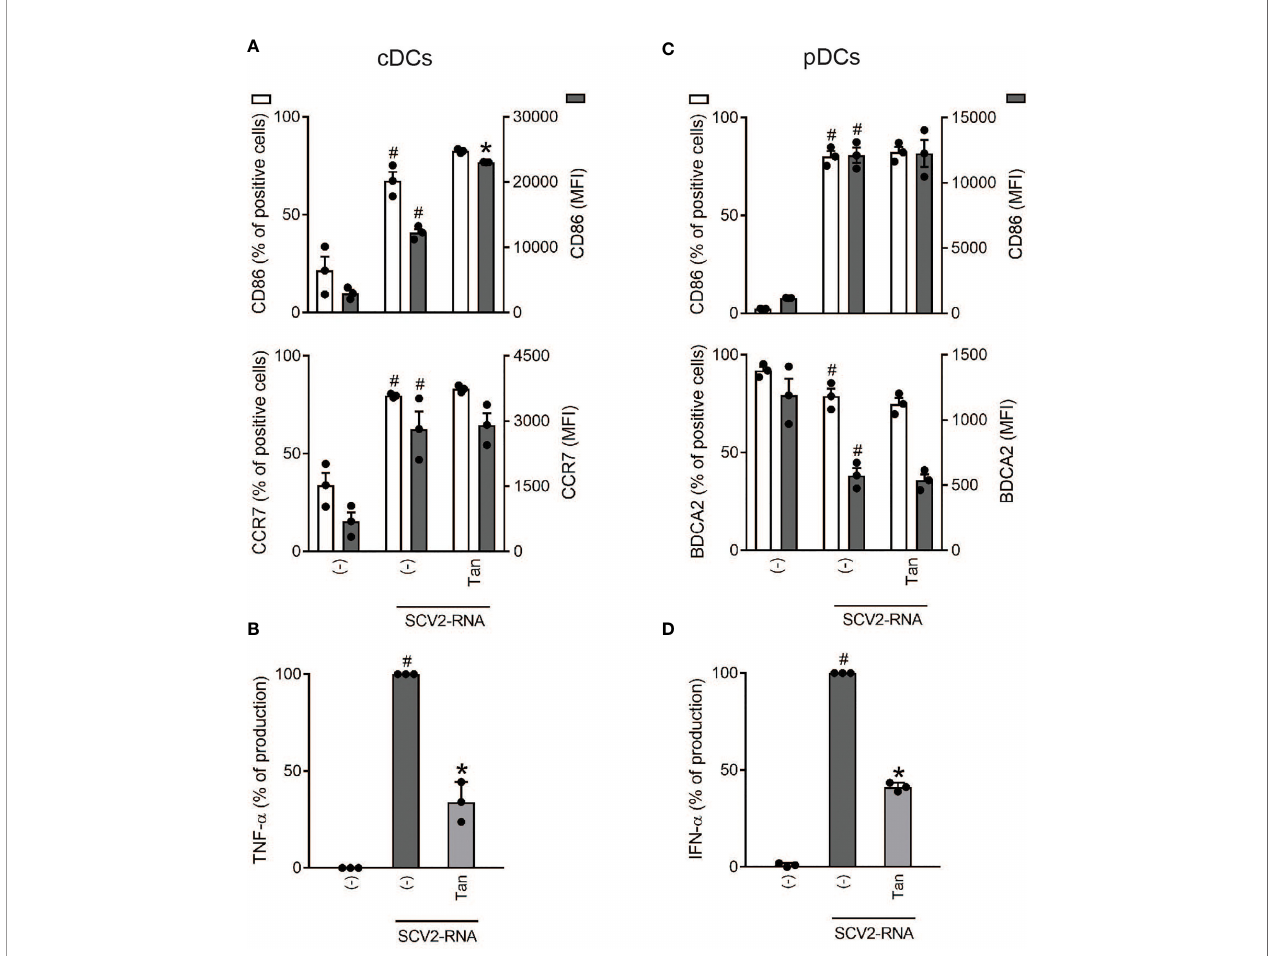
FIGURE 5 | Effect of Tanimilast on primary DC activation by SCV2-RNA. cDCs (2x10 6 /ml) and pDCs (1x10 6 /ml) were pre-treated with Tanimilast (Tan, 10 -7 M) and then stimulated with SCV2-RNA for 24 hours. (A, C) The surface expression of CD86, CCR7 and BDCA2 was evaluated by FACS analysis. Data are expressed as the mean ± SEM (n=3) of the percentage of positive cells (left y axis) and of the Median Fluorescence Intensity (MFI) (right y axis). (B, D) The production of TNF- a and IFN- a was evaluated by ELISA in cell-free supernatants. Cytokine expression is normalized to SCV2-RNA condition (represented as 100%). Absolute levels of SCV2-RNA induced cytokines (ng/ml) were: TNF- a = 20.92 ± 0.55; IFN- a = 169.36 ± 23.39. Data are expressed as mean ± SEM (n=3). (A – D) # P< 0.05 versus (-) and *P< 0.05 versus SCV2-RNA by one-way ANOVA with Dunnett ’ s post-hoc